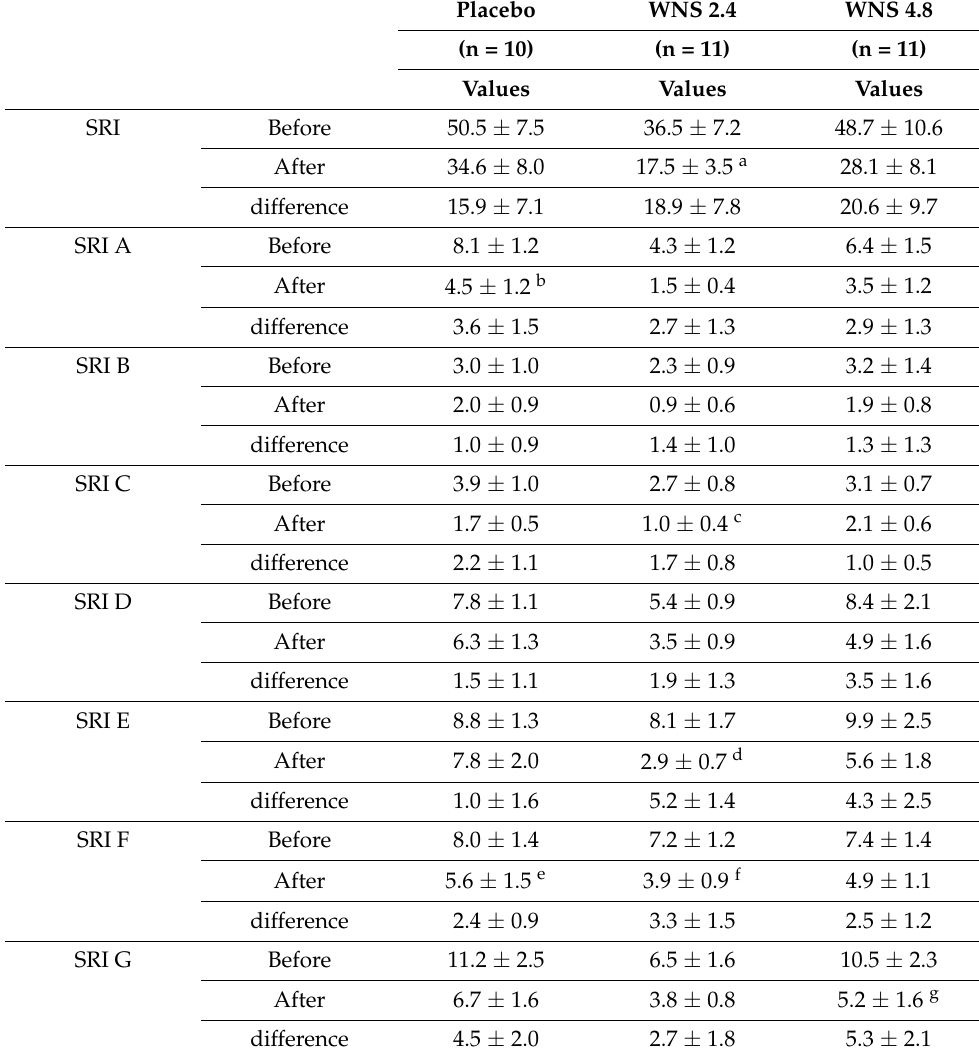
Figure 5. Differences in SRI mean scores between WNS and placebo groups. ( A ) Placebo group, (b) 2.4 g of WNS group, ( C ) 4.8 g of WNS group.